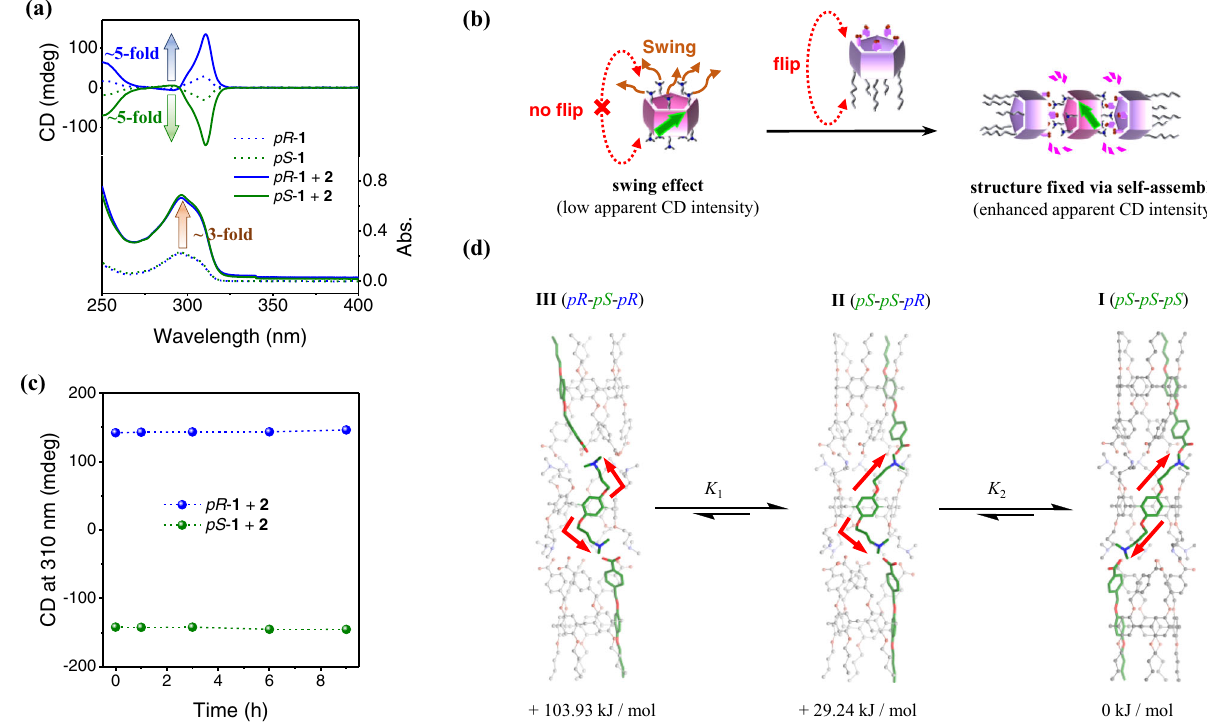
Fig.2|Spectralresultsandproposedchiralitytransferfromenantiomeric 1 to 2 by trimerization. a UV – Vis and CD spectra (chloroform, 25°C) of pR - 1 , pS - 1 , and mixturesof 2 with pR - 1 or pS - 1 .Theconcentrationsof 1 and 2 were0.05and0.1mM, respectively. b Schematic of the swing effect of pS - 1 on CD intensity and structure fi xing via trimerization to suppress the swing effect. c CD intensity at 310nm of